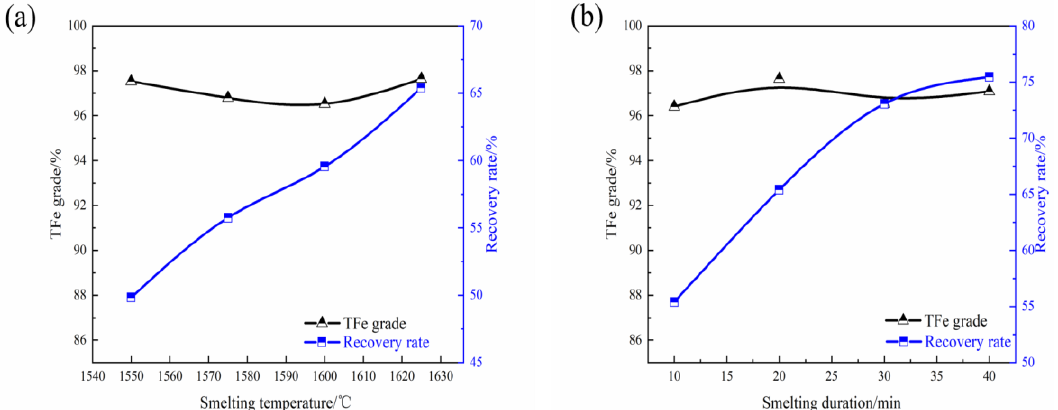
Figure 10. Effects of smelting separation parameters on the smelting separation of pre-reduced pellets. ( a ) Smelting at various temperature for 20 min with 10% soft coal, under natural basicity; ( b ) Smelting at 1625 °C with 10% soft coal, under natural basicity. (The yields of pig iron obtained at different smelting temperature were 20.56%, 22.97%, 24.94%, and 26.99%, respectively; The yields of pig iron obtained at different smelting duration were 23.09%, 26.96%. 30.45%, and 30.99%, respectively).